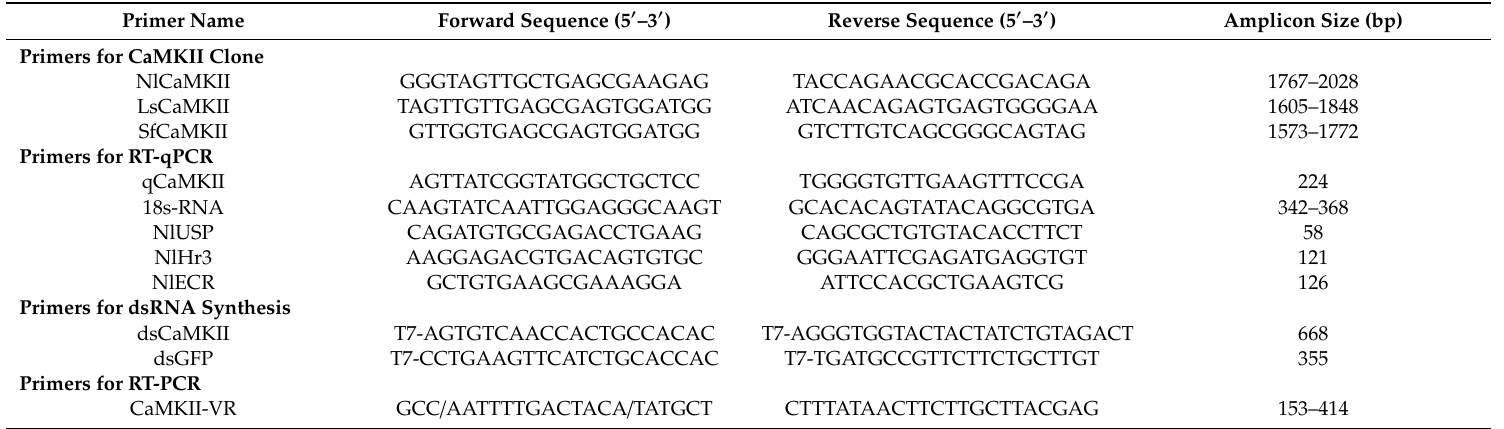
Table 3. Primers used in this